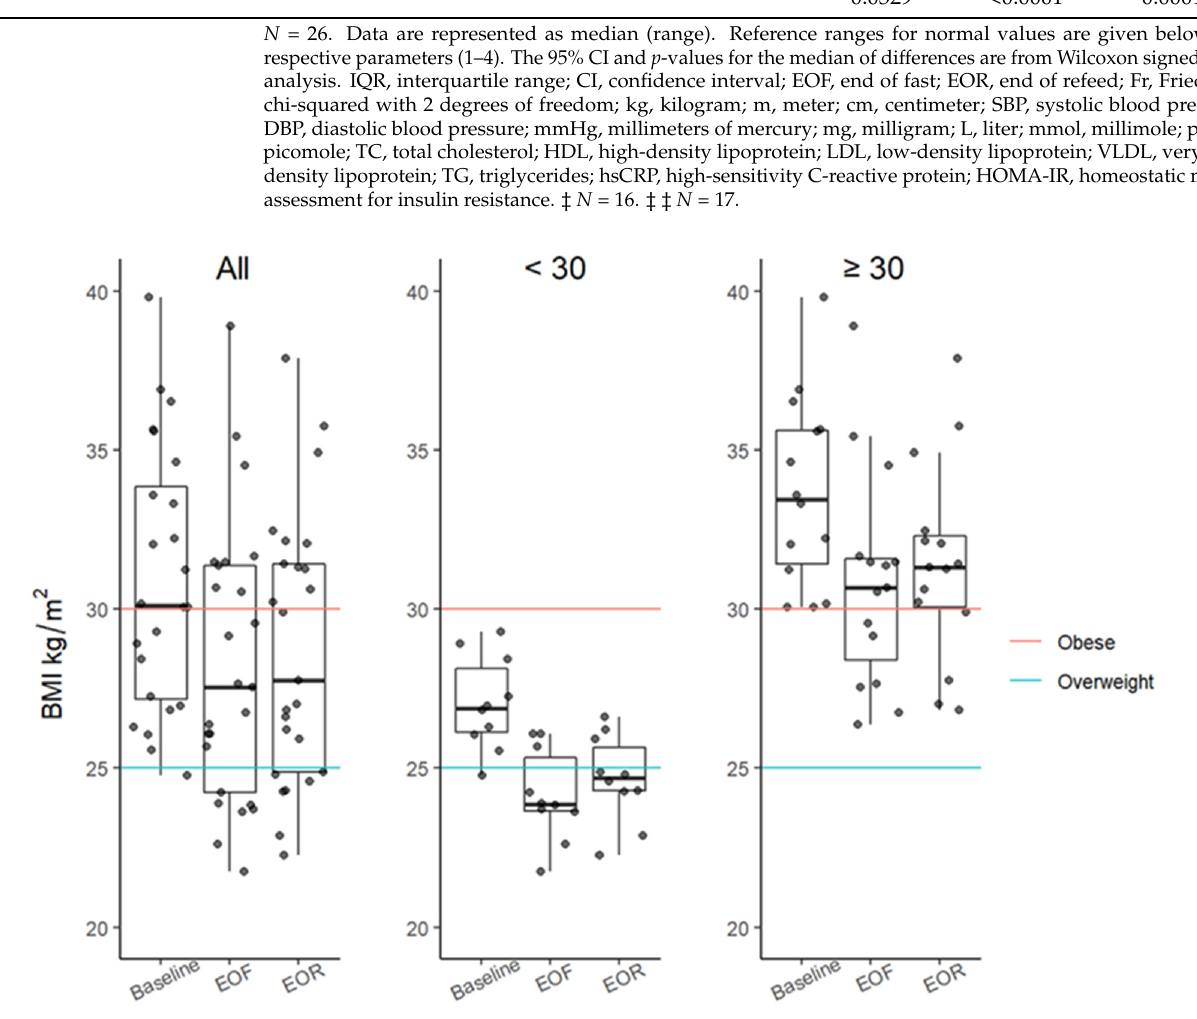
Figure 2. BMI boxplots at baseline, EOF, and EOR. Data further categorized based on obesity threshold ( ≥ 30 kg/m 2 ; red line). A BMI between 25 kg/m 2 (blue line) and 29 kg/m 2 is overweight. Boxplots represent the minimum value, first (lower) and third (upper) quartiles, the median, and the maximum value. EOF, end of fast; EOR, end of refeed; BMI, body mass index; kg, kilogram; m, meter. The median AC decreased from 97.6 cm at baseline to 90.7 cm and 90.8 cm at EOF and EOR, respectively. These differences were significant with MODs of − 7.1 cm ( p < 0.0001), − 5.7 cm ( p < 0.0001), and 1.7 cm ( p = 0.0054) from baseline to EOF and baseline to EOR, respectively (Table 1 and Supplemental Table S2). A 1-day increase in fasting